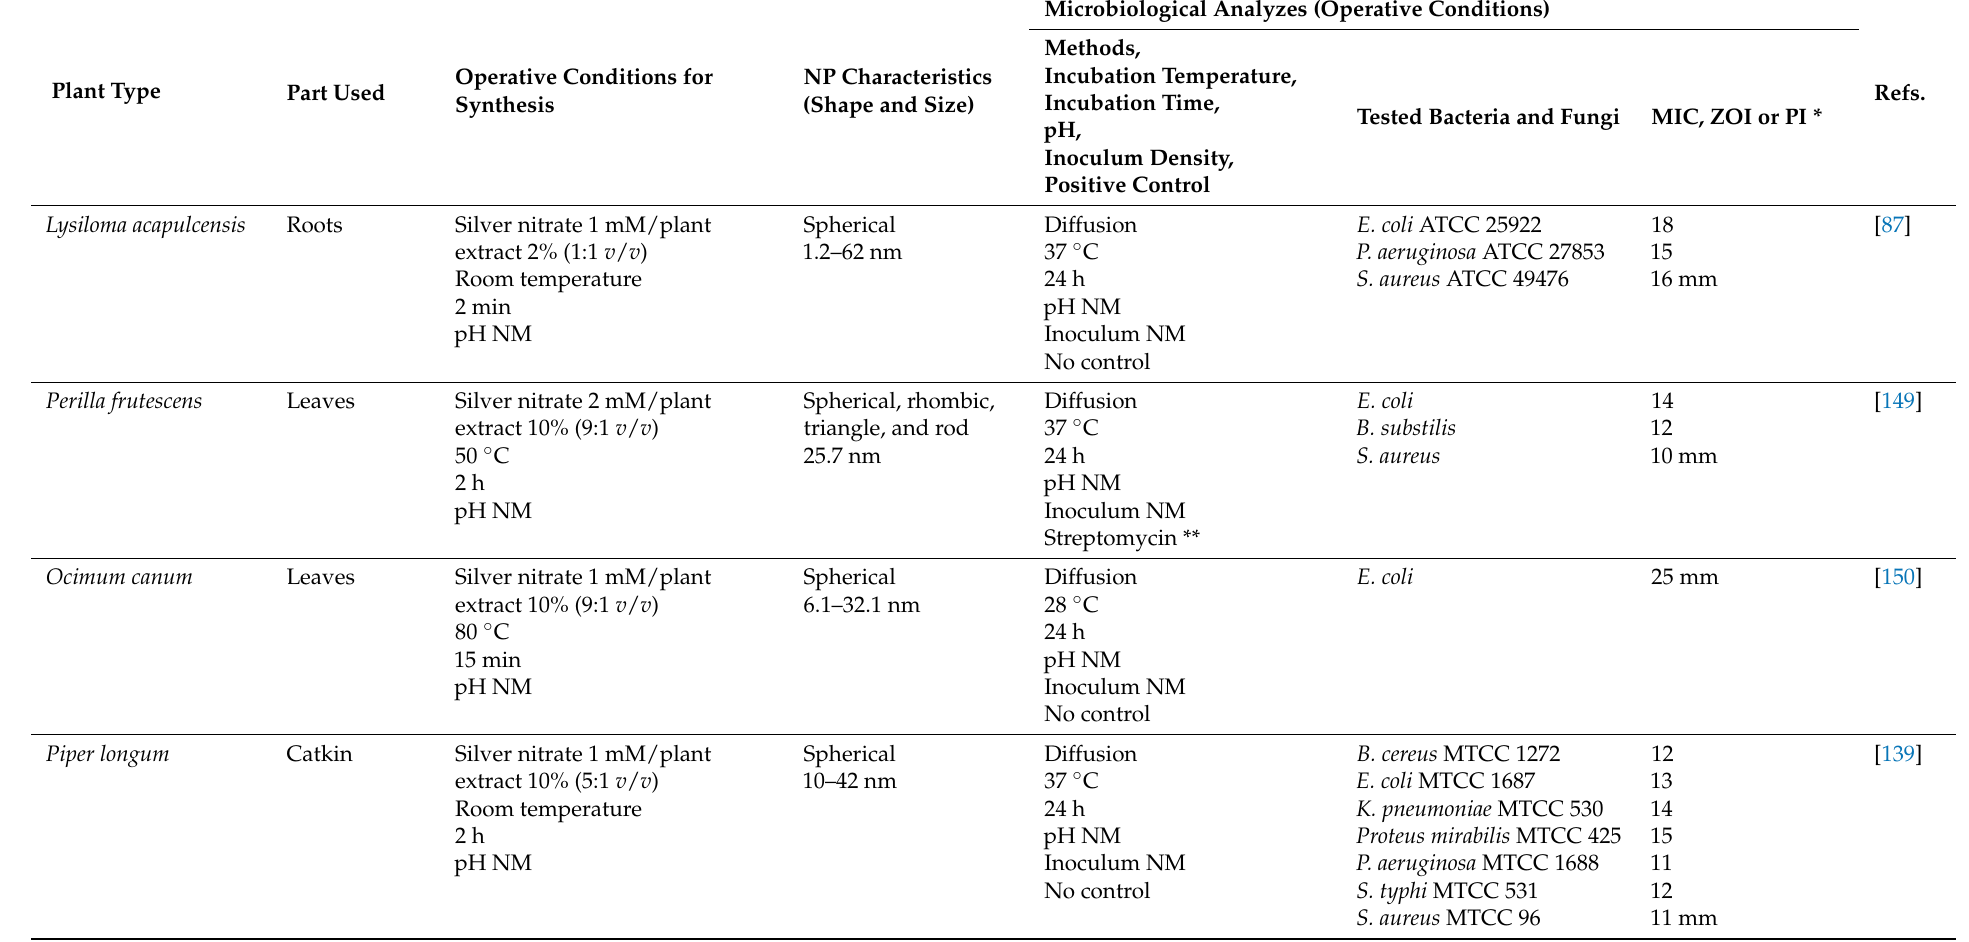
Table 1. Green silver nanoparticles exhibiting antimicrobial